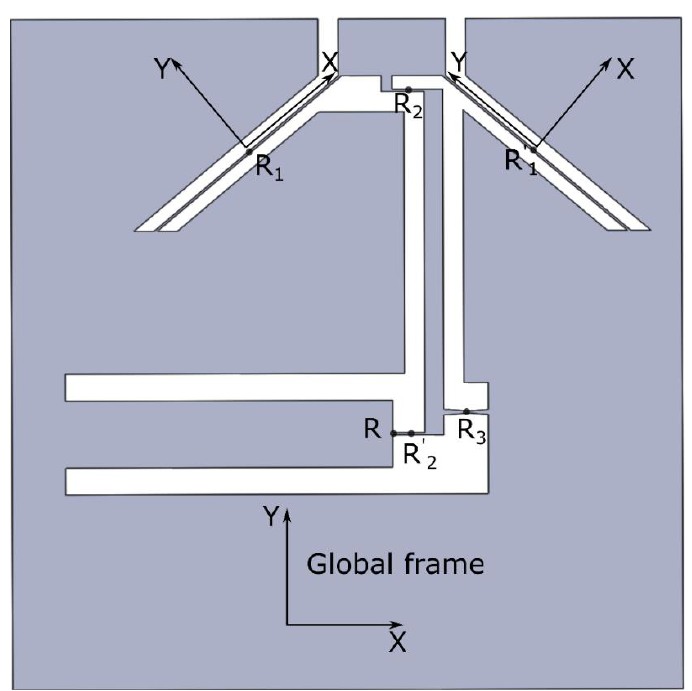
Figure A1. A 2D representation of the device showing the beams in their respective coordinate frames. The coordinate frames centered at R 2 , R ’ 2 , and R 3 have the same orientation as the global frame at